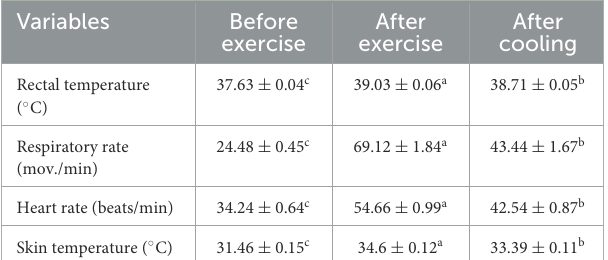
TABLE 2 Means and standard deviation of physiological variables and adaptability indices of horses, before exercise, after exercise and after cooling down, in the experimental area, in Ananindeua, Pará.